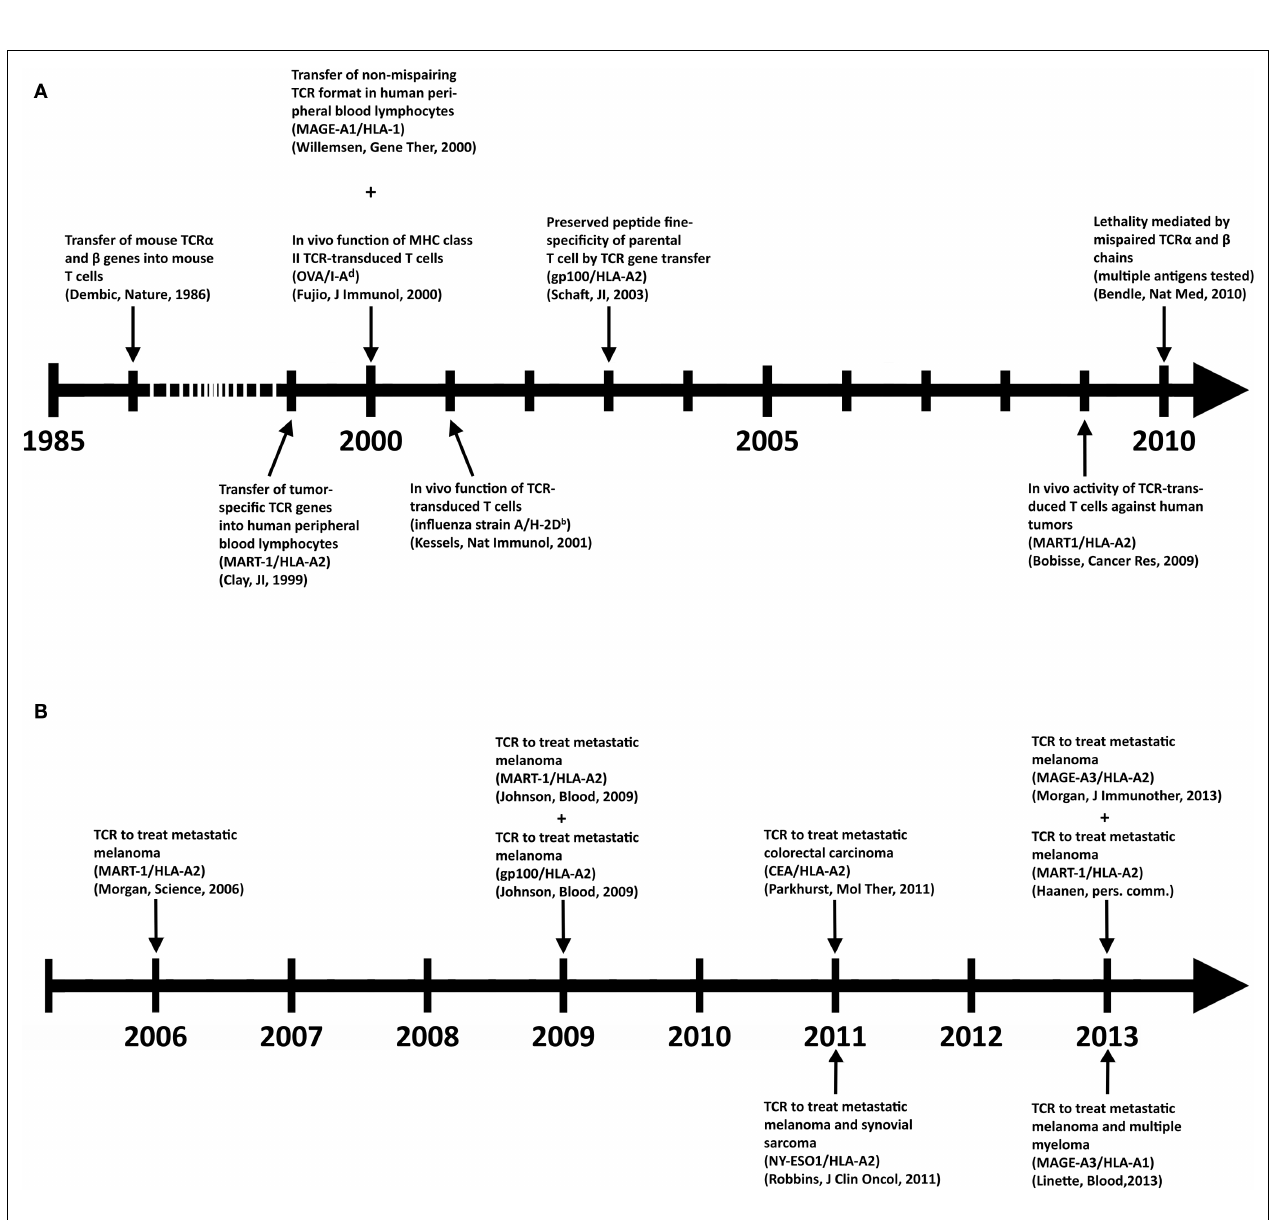
therapy. (B) Timeline of clinical findings withTCR gene-engineeredT cells. Details with respect to clinically usedTCRs can be found